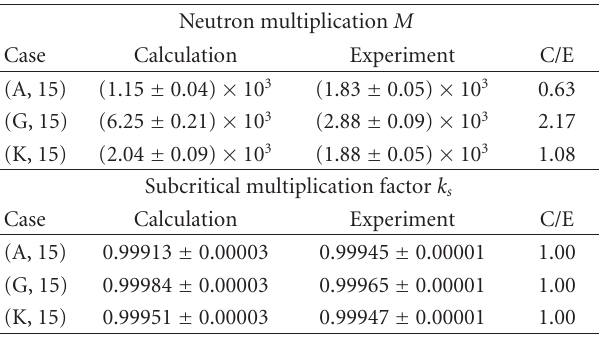
Table 4: Comparison between the measured and calculated neu- tron multiplication and subcritical multiplication factor obtained from the experiments (Figure 5) and calculations (MCNPX with